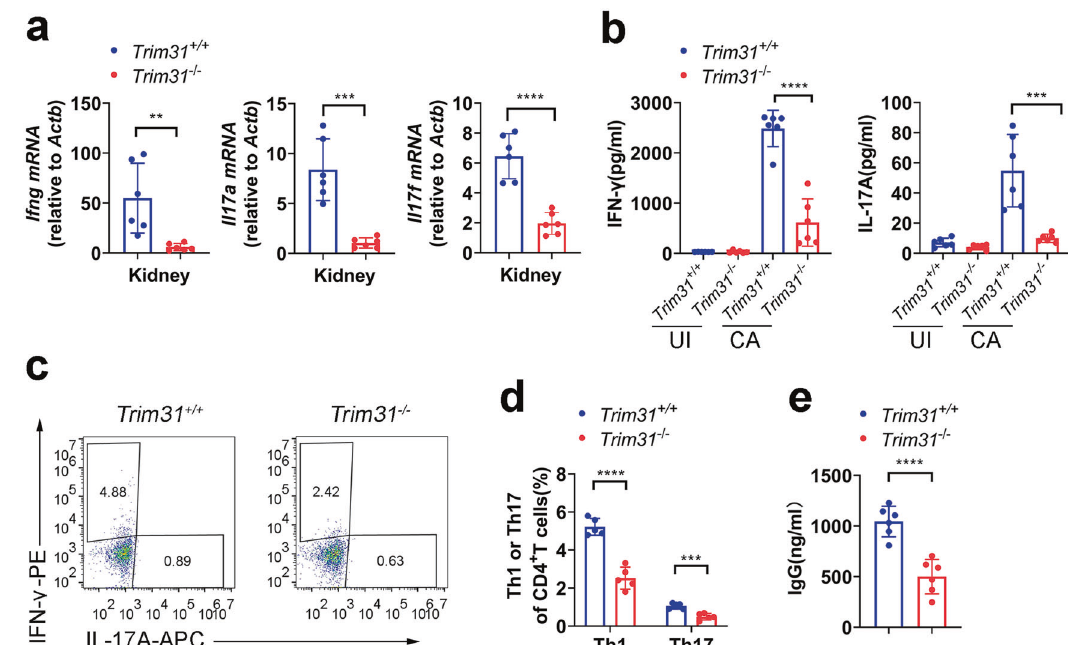
Fig. 3 TRIM31 is indispensable for anti-fungal Th1 and Th17 responses. a qRT-PCR analysis of Ifng , Il17a , and Il17f from kidneys of Trim31 + / + ( n = 6) and Trim31 − / − ( n = 6) mice infected with C. albicans (2 × 10 5 fungal cells per mouse) for 5 days. b ELISA analysis of IFN- γ (left) and IL-17A (right) in the supernatant of splenic cells obtained from Trim31 + / + and Trim31 − / − mice ( n = 6 per group) infected with C. albicans (2 × 10 5 fungal cells per mouse) for 5 days, followed by stimulation with HKCA-Y (MOI, 1) for 2 days. c , d Splenic cells isolated from the Trim31 + / + or Trim31 − / − mice and stimulated as in ( b ). Intracellular staining of IFN- γ (Th1) and IL-17A (Th17) were determined with fl ow cytometry. The representative fi gure is shown in ( c ), and the results are summarized in ( d ). e ELISA analysis of IgG in serum from Trim31 + / + and Trim31 − / − mice ( n = 6 per group) infected with C. albicans (2 × 10 5 fungal cells per mouse) for 5 days. * P < 0.05; ** P < 0.01; *** P < 0.001; and **** P < 0.0001 (Student ’ s t -test in a , b , d , e ). Data are from one experiment representative of three independent experiments ( a , b , d , e ; mean ±